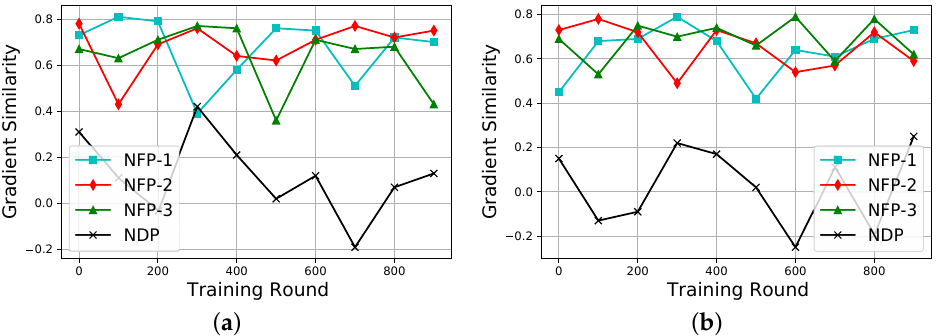
Figure 4. Variation of gradient similarity against the number of training rounds. ( a ) NDP noise data are 30%. ( b ) NDP noise data are